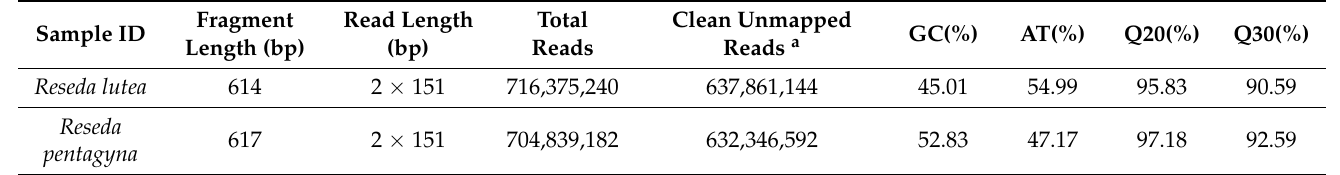
Table 3. Summary statistics for Reseda lutea and Reseda pentagyna genome sequences.